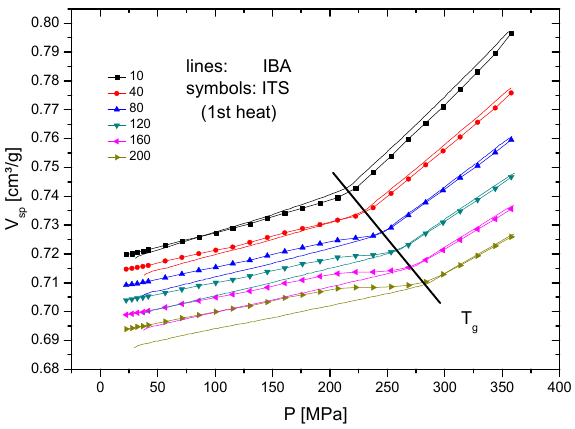
Figure 3. ( a ) Isotherms of PES 4100P obtained with rising temperature (legend gives T in °C) and ( b ) isotherms converted to isobars (legend gives pressure in MPa).